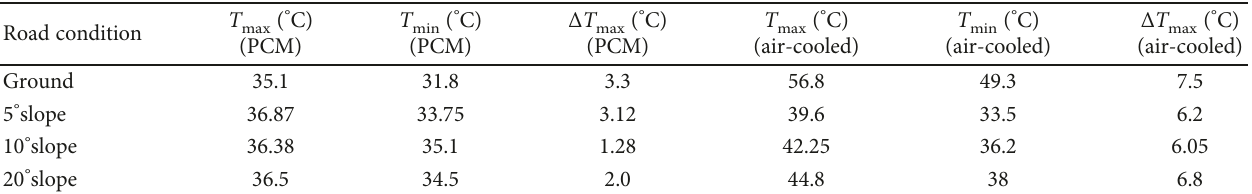
meant number 4 cell). max Table 2: Comparison of experimental